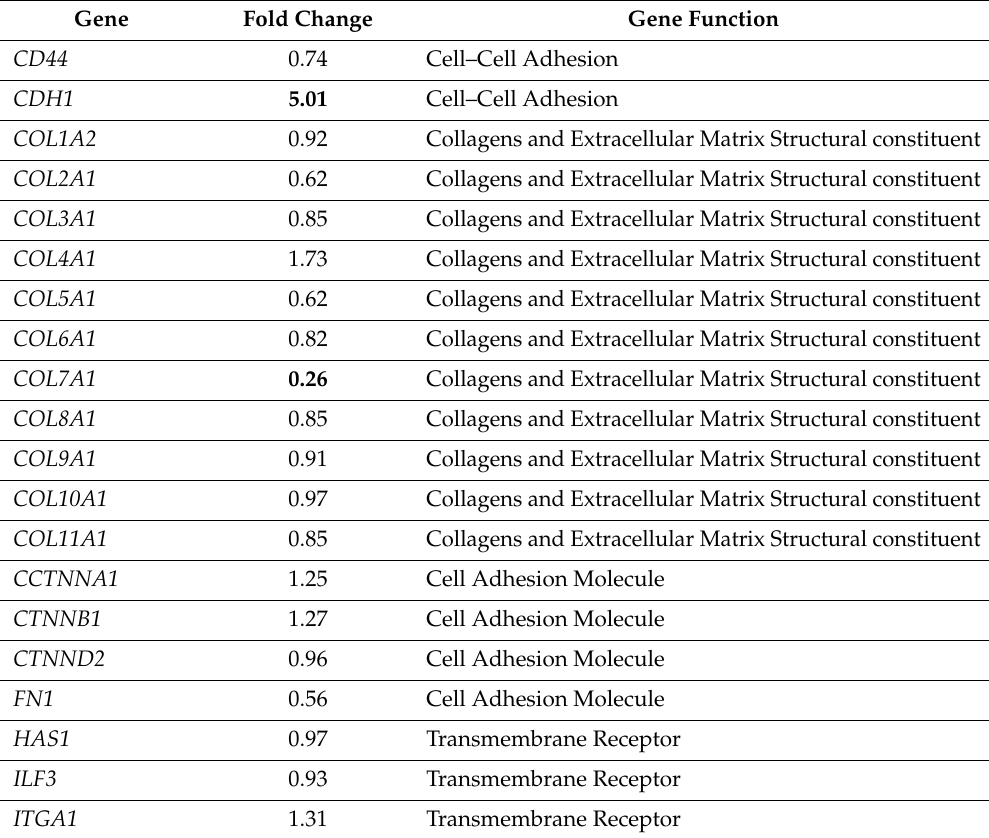
Figure 2. Gene expression profile of fibroblasts treated with cyclosporine A 1000 ng/mL.